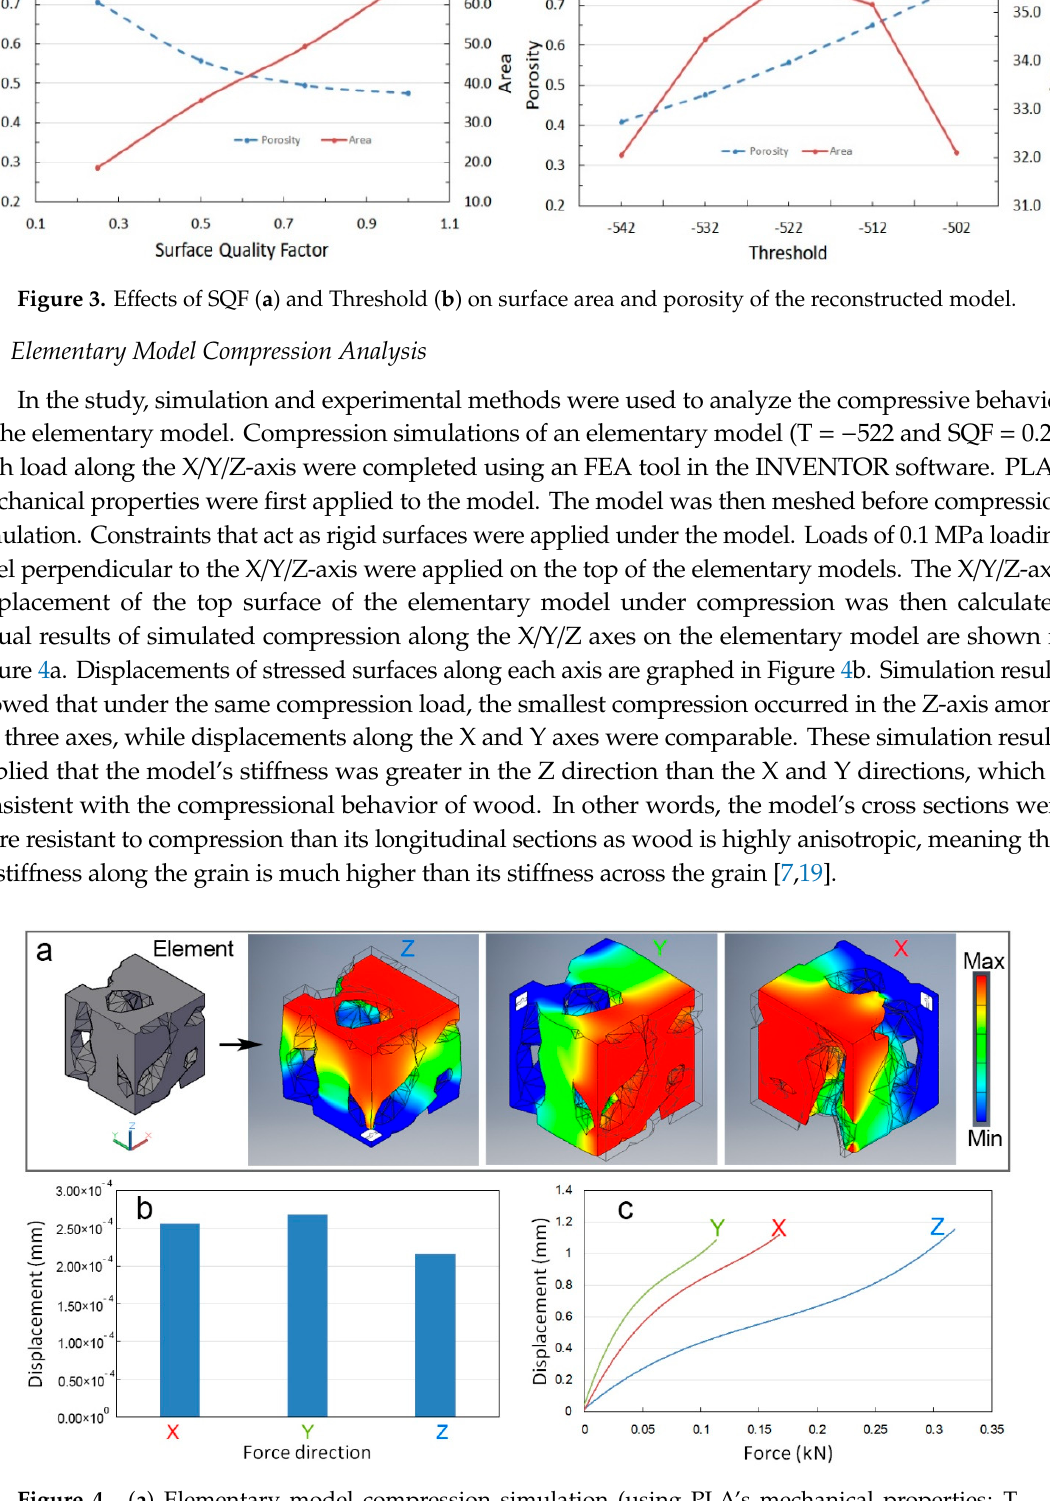
Figure 4. ( a ) Elementary model compression simulation (using PLA’s mechanical properties; T factor of the model was -522 and SQF factor was 0.25); ( b ) Displacement of stressed surfaces in the direction of each axis; ( c ) Plot of force vs. displacement for each axis from printed elementary model compression experiments.